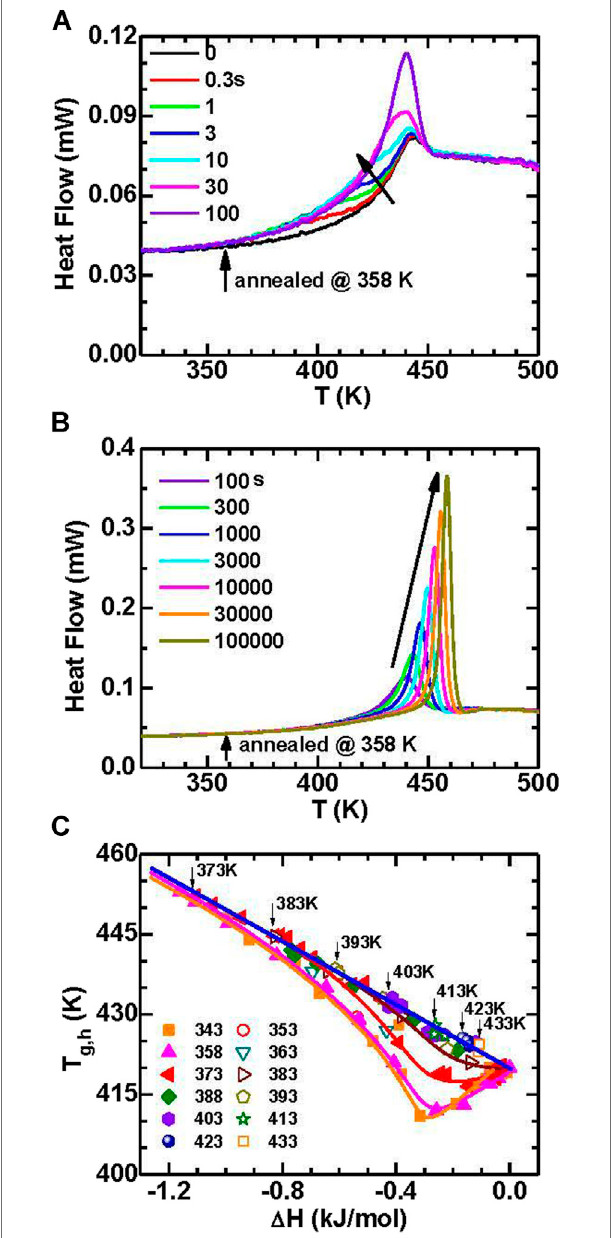
FIGURE 14 | (A) The heat fl ow traces annealed at 358 K for short times ( ≤ 100 s) in Au 49 Cu 26.9 Ag 5.5 Pd 2.3 Si 16.3 MG. (B) The heat fl ow traces for the annealed sample at 358 K for long times ( ≥ 100 s). (C) Correlation of T g,h and theenthalpychangeforsamplesannealedatvarioustemperatures(from (Wang et al.,